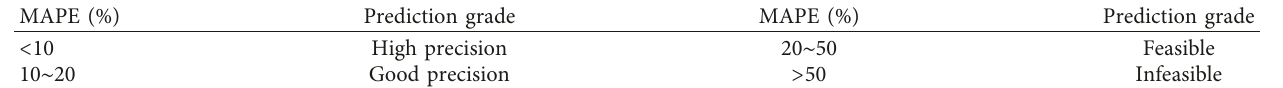
Table 3: Classification of MAPE prediction grades